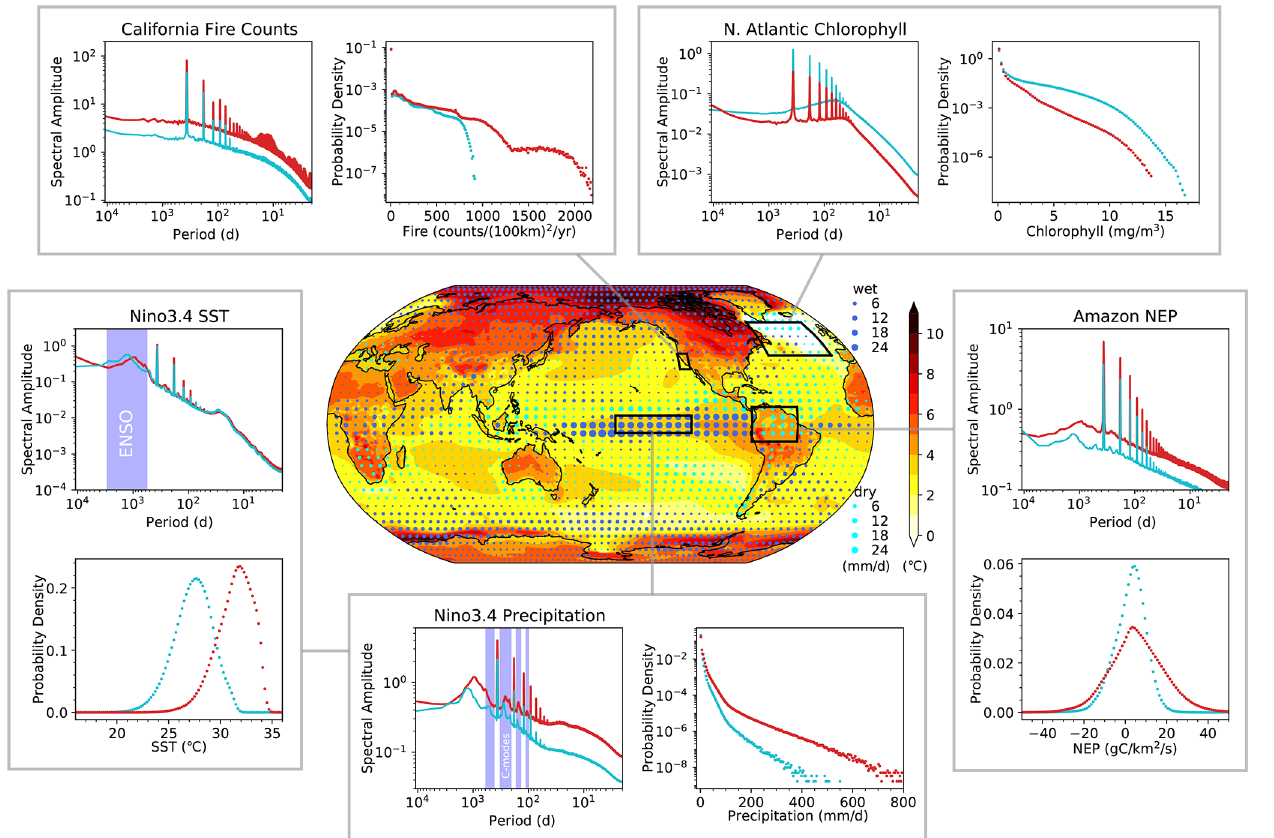
Figure 2. Changes in the Fourier amplitude spectrum of historical (1960–1989) to future (2070–2099) climate variability in CESM2-LE. The center map shows historical-to-future changes in surface temperature (shaded, ◦ C) and precipitation (solid blue/cyan dots, mmd − 1 ). Each pairing of panels shows historical (cyan) and future (red) spectra and PDFs for five different variables over four different regions. The spectra are considered over the respective periods, 1960–1989 (historical) and 2070–2099 (future), thereby including the trend, and PDFs are considered for all days over 1980–1989 and 2090–2099 to minimize the impact of the trend. From upper-left clockwise, each pair of panels shows fire occurrences in California (32 ◦ –41 ◦ N, 125 ◦ –118 ◦ W, land only), surface chlorophyll concentrations in the North Atlantic subpolar gyre (40 ◦ –60 ◦ N, 60 ◦ –15 ◦ W), net ecosystem production (NEP) in the Amazon (10 ◦ S–10 ◦ N, 80 ◦ –50 ◦ W, land only), precipitation over the Niño 3.4 regions (5 ◦ S–5 ◦ N, 170 ◦ –120 ◦ W), and sea surface temperature (SST) over the Niño 3.4 region. The spectra are calculated for daily time series at individual grid points including both forced responses and internal variability and using 30-year intervals. Subsequently the spectra are averaged over the grid points in each region. Sharp spectral peaks are associated with the annual cycle and its non-sinusoidal components, which generate high-order harmonics. Shaded areas for spectra of precipitation and temperature in the Niño 3.4 region correspond to the timescales of the El Niño–Southern Oscillation (ENSO) and ENSO-annual-cycle combination modes (Stuecker et al., 2013) (C modes). Spectra are shown as amplitude, with the units being the same as the x axes for the PDFs. PDFs of positive variables (California fire counts, North Atlantic surface chlorophyll, and Niño 3.4 precipitation) are shown with logarithmic y axes. The fields in the center panel are presented in more detail in Fig. S6, except that there 2m reference temperature is used rather than surface temperature. A suite of complementary spectral and PDF analyses to those shown here are presented in Fig.